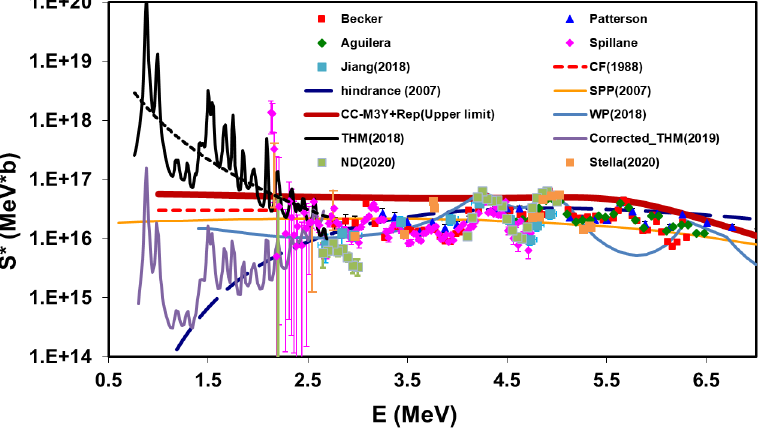
Figure 1. (Color online) S* factors of 12 C + 12 C. The 12 C + 12 C data from Ref. [7], [9], [11], [12], [14] and [15] shown as blue, red, green diamond, magenta, blue, green square and orange points, respectively. Model calculations, CC-M3Y + Rep (thick dark red), SPP(oragen), TDWP(light blue) and hindrance(blue dashed) are also shown, respectively. The recommended averaged S* factor by CF88 is shown as red dashed line. The THM result and the fit are shown as black dashed and solid lines,